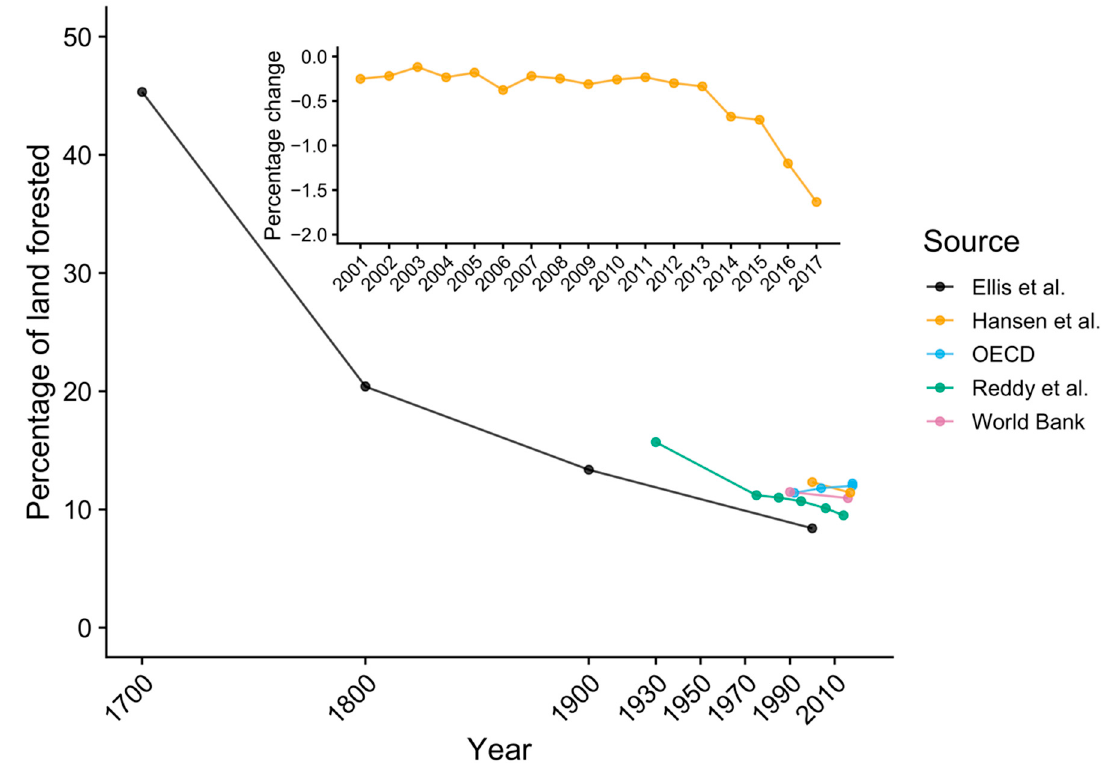
Figure 5. Historical change in forested land area in Bangladesh according to available sources. Inset displays the rate of dense forest loss (annual percentage change) since 2000, with a recent increase in this rate of decline, drawn from Hansen et al. [86]. A cutoff value of 40% was used to define dense forests. Only gross forest loss is displayed, since data on forest gain only cover the period 2000–2012.